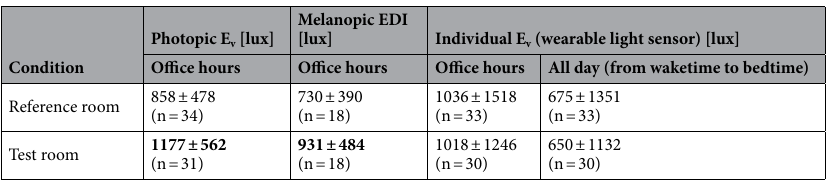
Table 1. Summary of lighting characteristics assessed during the study derived from stationary and wearable light sensors. Light exposure measurements: Stationary light sensors: E v = photopic illuminance, EDI = melanopic equivalent (D65) daylight illuminance (lux), both assessed on a vertical plane at the approximate eye level during office hours. Wearable light sensors: individual E v during office hours and during entire waking period (mean ± SD per hour across days and participants). Bold numbers (for photopic E v and melaonpic EDI) indicate significantly higher values in the Test room than the Reference room ( p < 0.05).